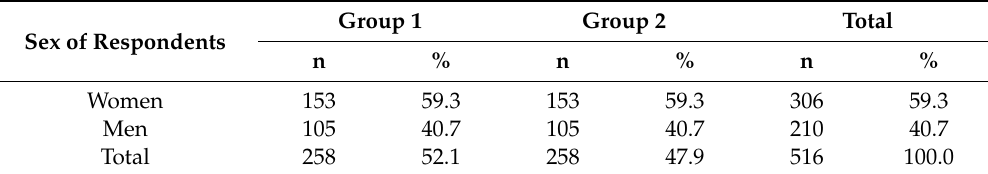
Table 2. Main characteristics of the study